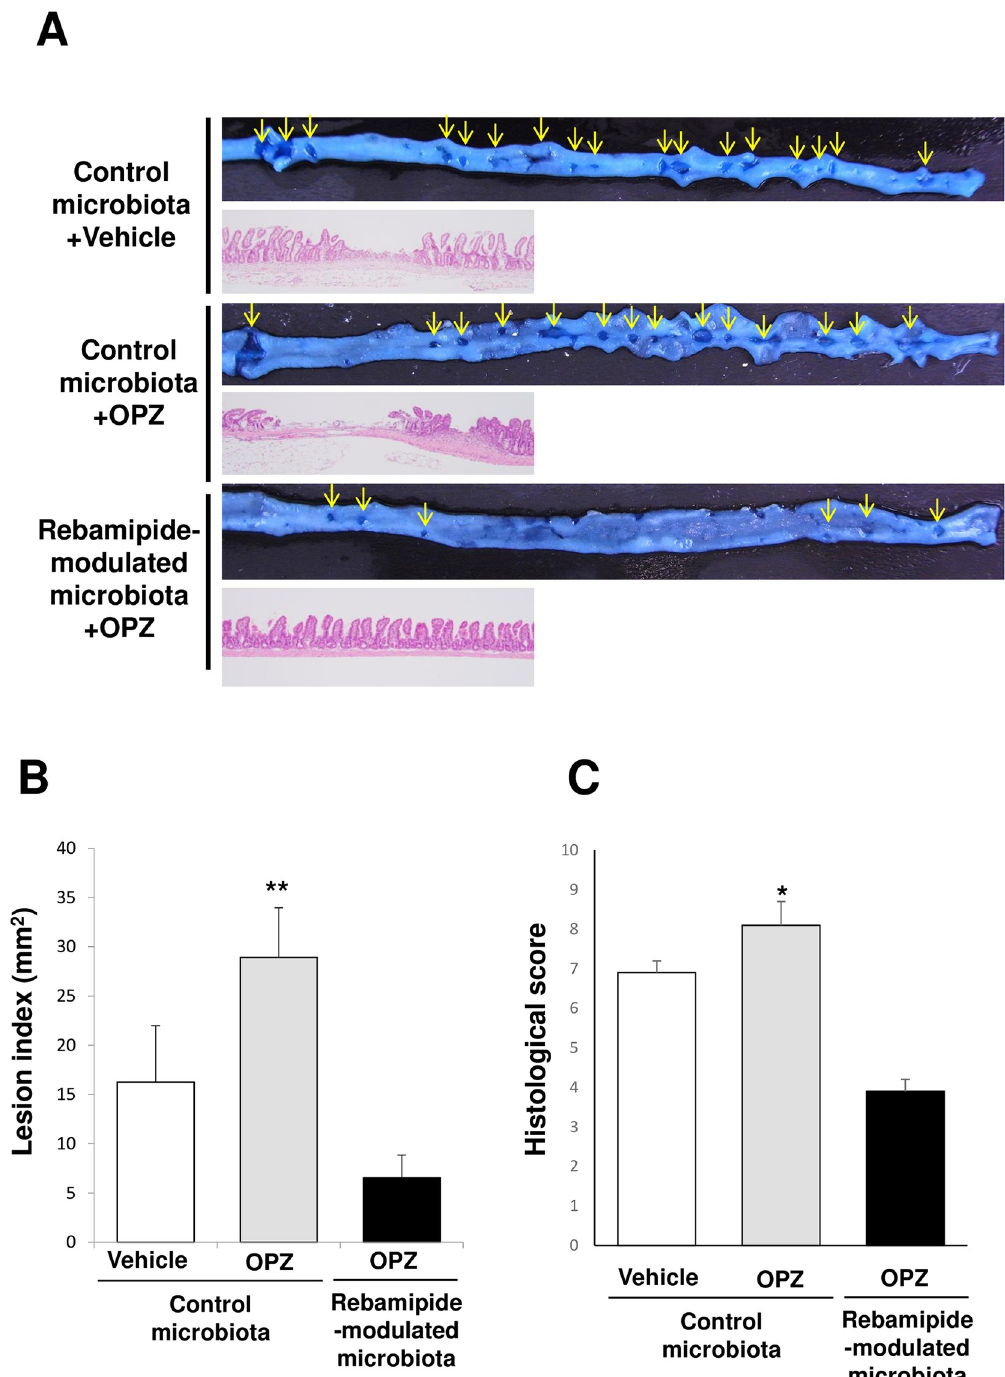
Fig 3. The deleterious effect of omeprazole and the inhibitory effects of rebamipide-modulated small intestinal microbiota on indomethacin-induced small intestinal damage. A. Typical macroscopic and histological image of indomethacin-induced small intestinal damage. Damaged mucosa (arrows) was stained dark blue with 1% Evans blue. B. Lesion indices of indomethacin-induced small intestinal damage. C. Histological score of indomethacin-induced small intestinal damage. OPZ: omeprazole Each column represents the mean ± standard error of the mean (S.E.M.). N = 6–7. � p < 0.05 and �� p < 0.01 vs. vehicle-administered mice transplanted with control microbiota.